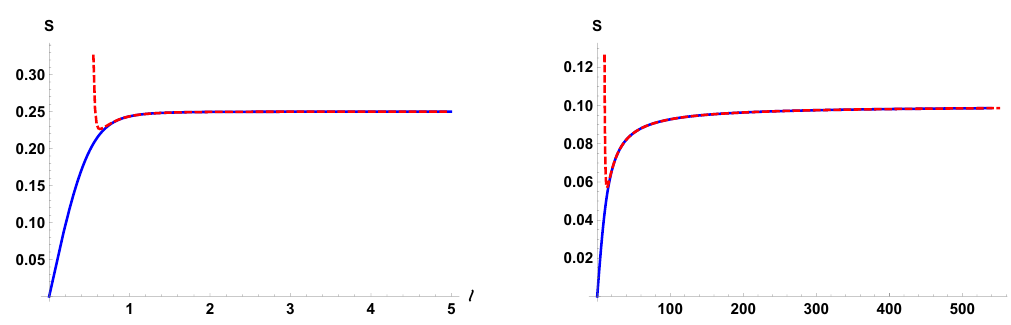
Figure 6 . HEE as a function of ‘ for different values of the cutoff: Left) r c = 1 and d e = 5 Right) r c = 10 and d e = 2 . The red dashed curves are based on the perturbative expression given in eq. (3.22) which is valid for very large entangling regions, and the solid blue curves are numerical results based on eq.